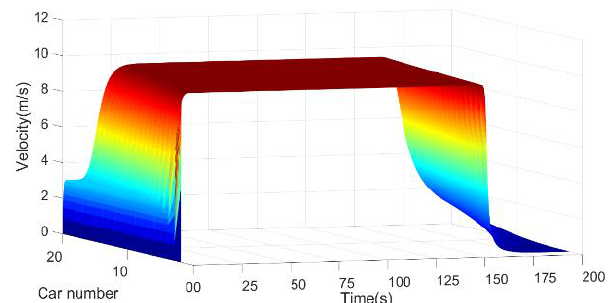
Figure 3. Vehicle velocities in driving situation 1.